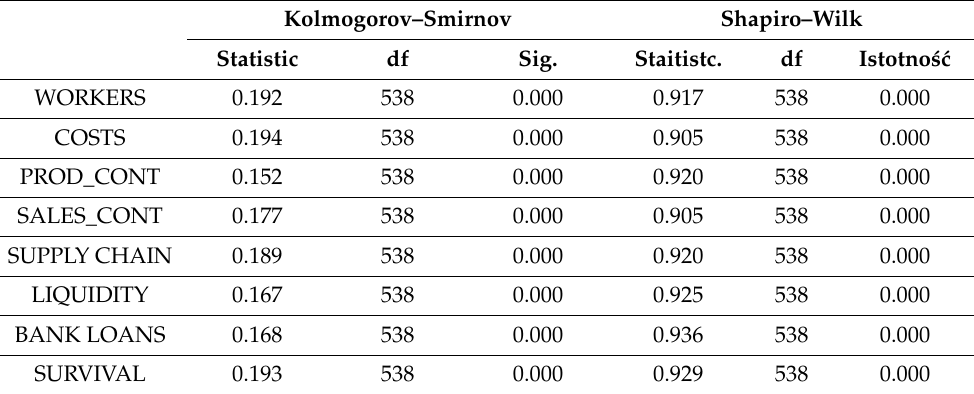
Table A1. Tests of normality distribution.